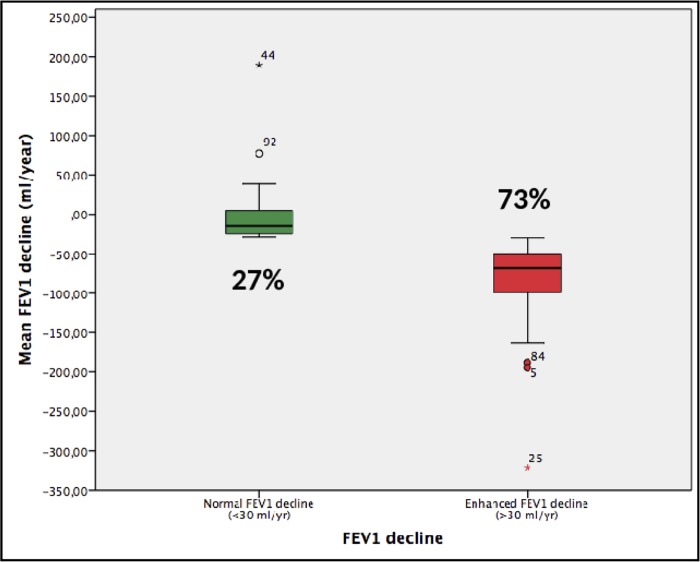
Box plot comparing the absolute FEV1 annual change in patients with normal (27%) or abnormal (73%) rate of FEV1 decline.For further explanations, see text.